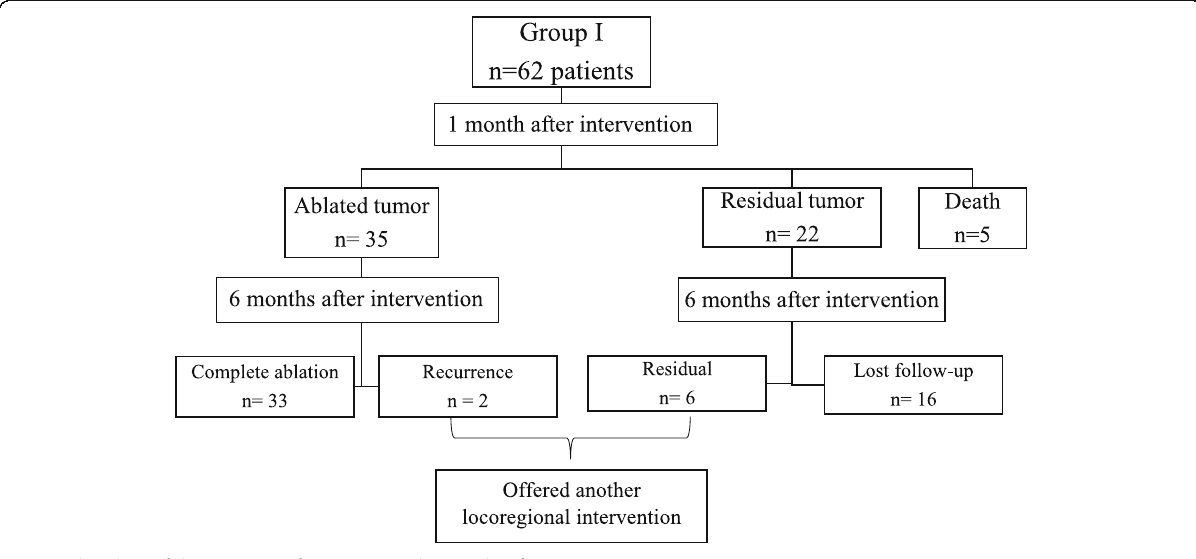
Fig. 1 Flowchart of the outcome of patients 1 and 6 months after intervention in group